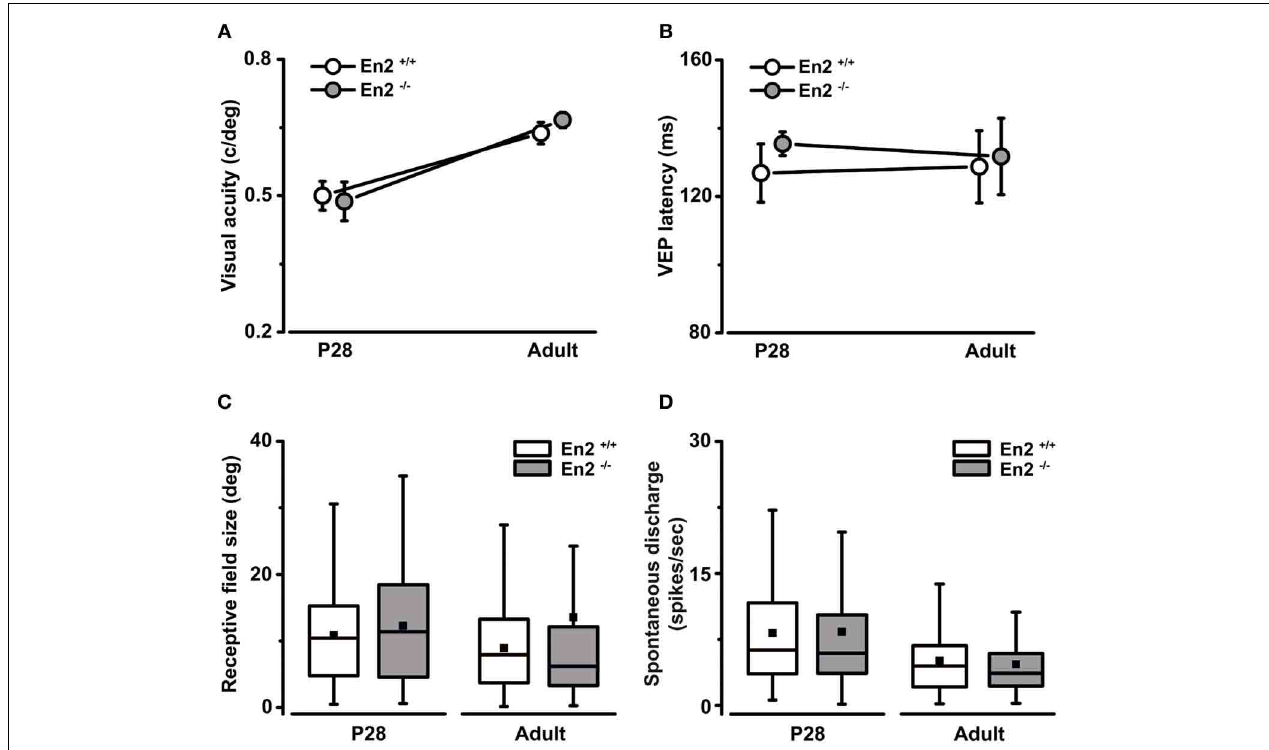
single-unit recordings from visual cortical neurons showed no significant difference between En2 + / + (white) and En2 − / − (gray) mice in terms of receptive field size (C) and spontaneous activity (D) at either age. Data are summarized by box charts. Horizontal lines in the box chart denote the 25th, 50th, and 75th percentile values, the error bars denote the 5th and 95th percentile values while the square indicates the mean of the